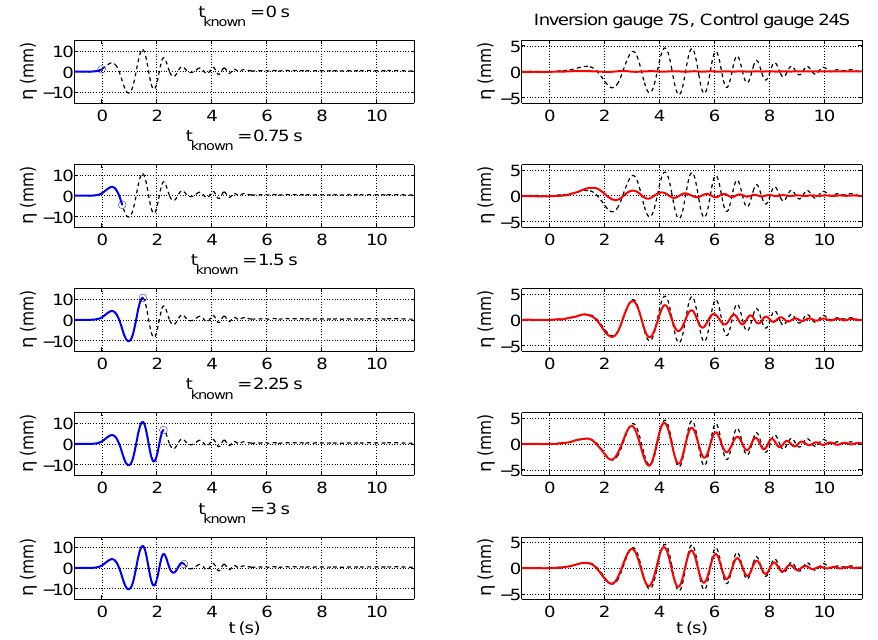
Fig. 9. Sample computations of real-time inversion using partial input time series at gauge 7S; results checked against records at gauge 24S.